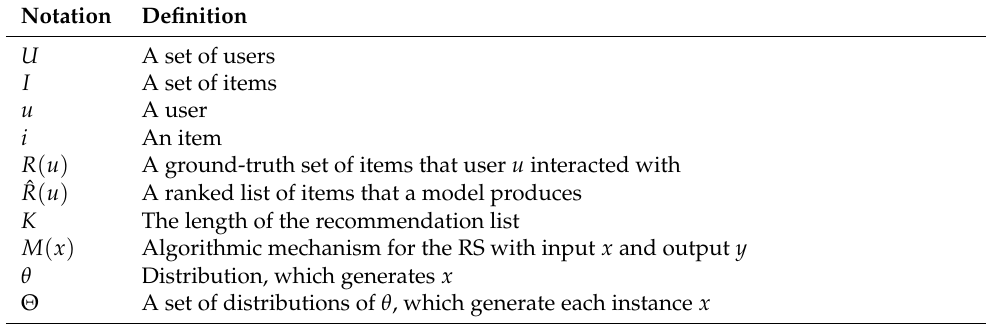
Table 4. Table of notations.